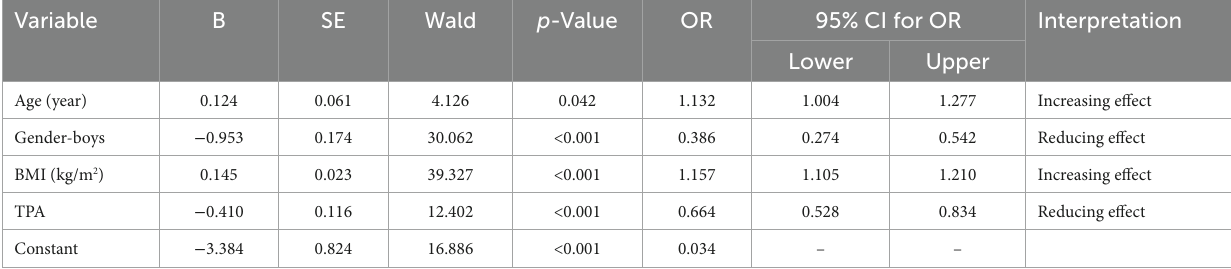
TABLE 5 Results of the logistic regression model created to predict DGA.